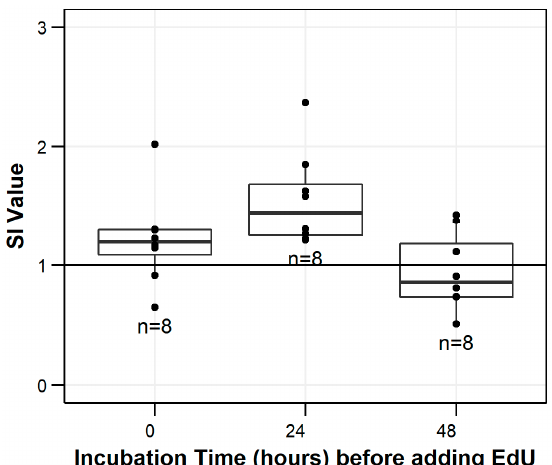
Figure 2. Stimulation index (SI) values for different incubation times of leukocytes isolated from laboratory-reared smallmouth bass ( Micropterus dolomieu ). Leukocytes were incubated with LPS and mitogen-free media (negative controls) for 0, 24, and 48 h before adding 5-ethynyl-2 ′ -deoxyuridine (EdU) to detect cell proliferation. The horizontal line indicates the stimulation index (SI) threshold of 1, the dots represent individual data points, and the number indicates sample size (n).